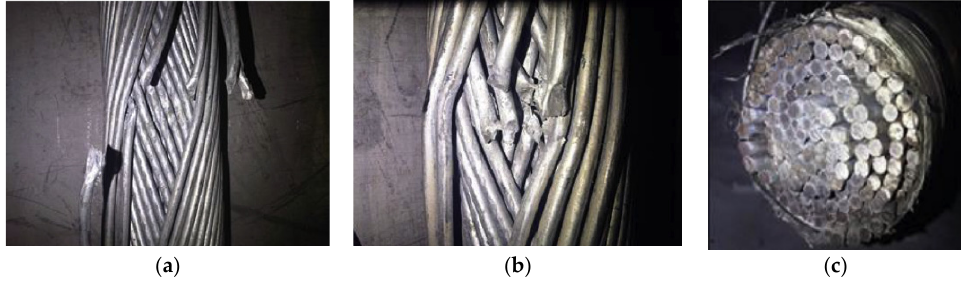
Figure 14. Fragment penetration of local wires presented and the ends of cable samples observed by Judge et al. [33]: ( a , b ) wire failure under impact of V 0 = 360 m/s, V 0 = 501 m/s; ( c ) the ends of cable samples of V 0 = 1320 m/s.